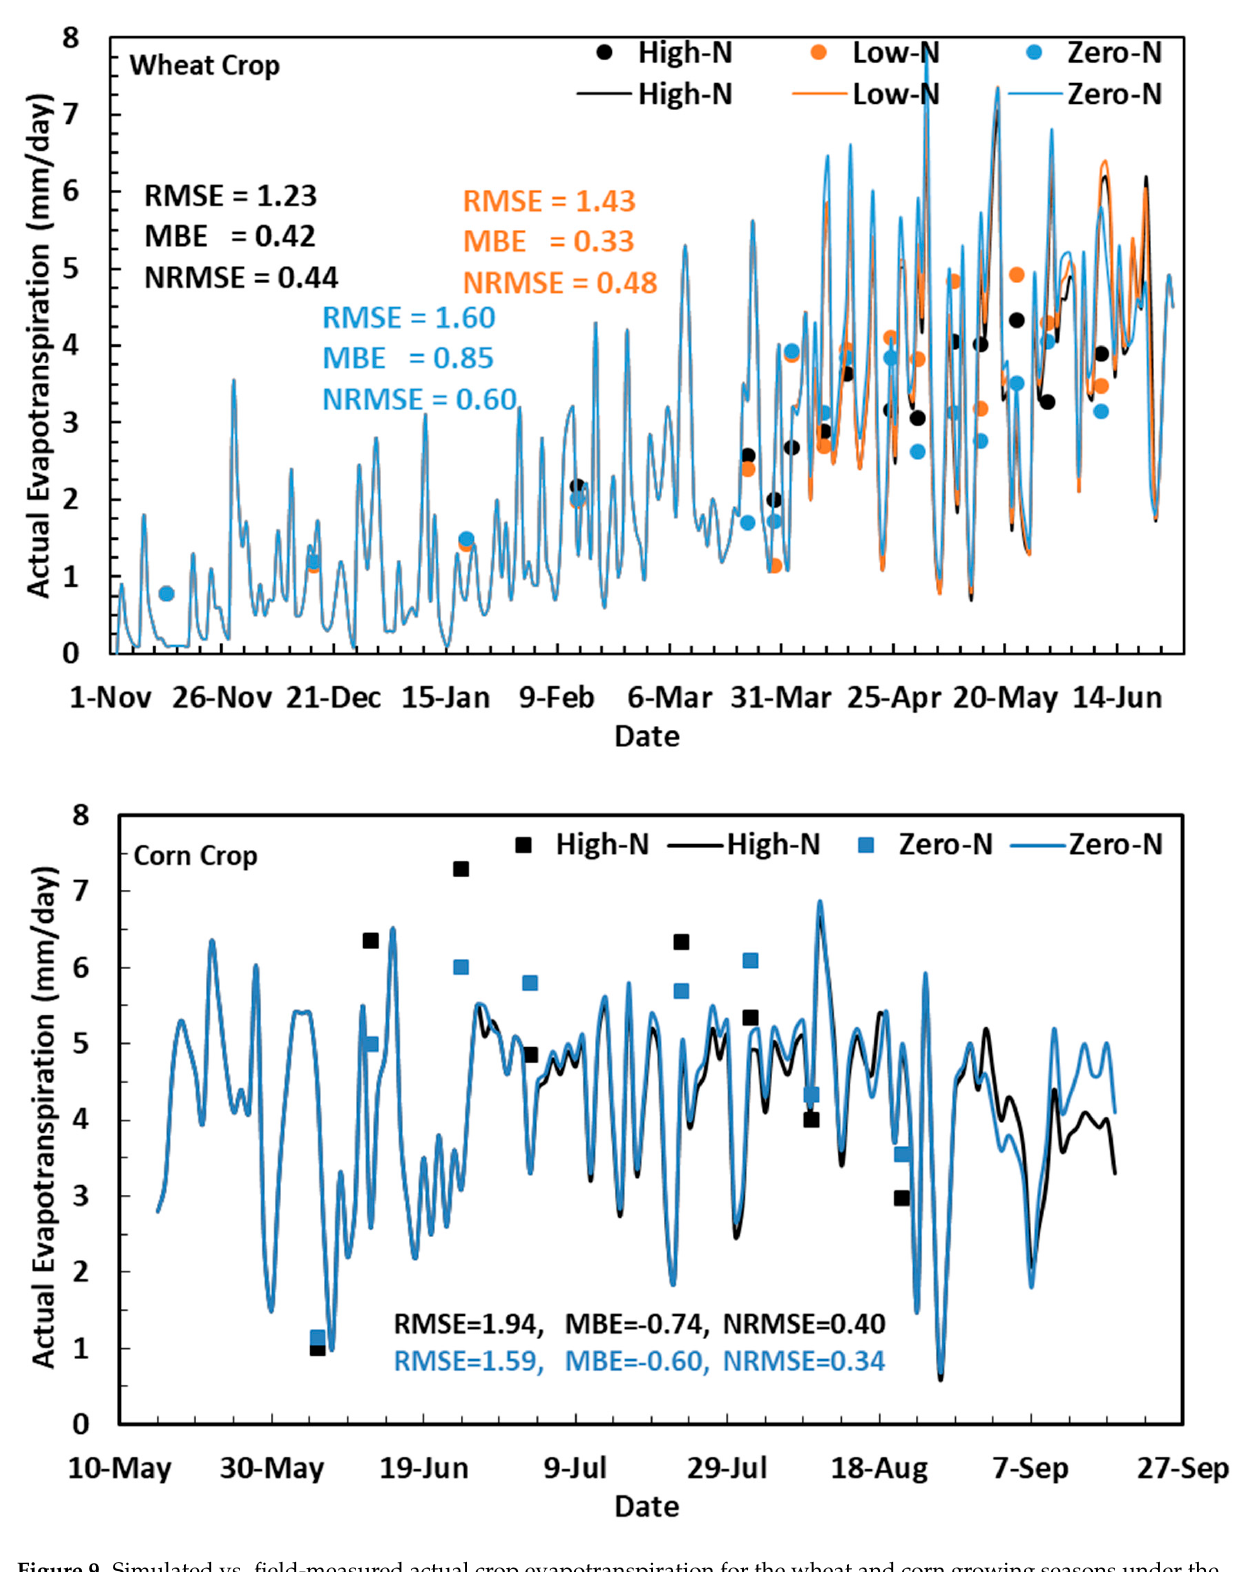
Figure 9. Simulated vs. field-measured actual crop evapotranspiration for the wheat and corn growing seasons under the 100% rainfall scenario.